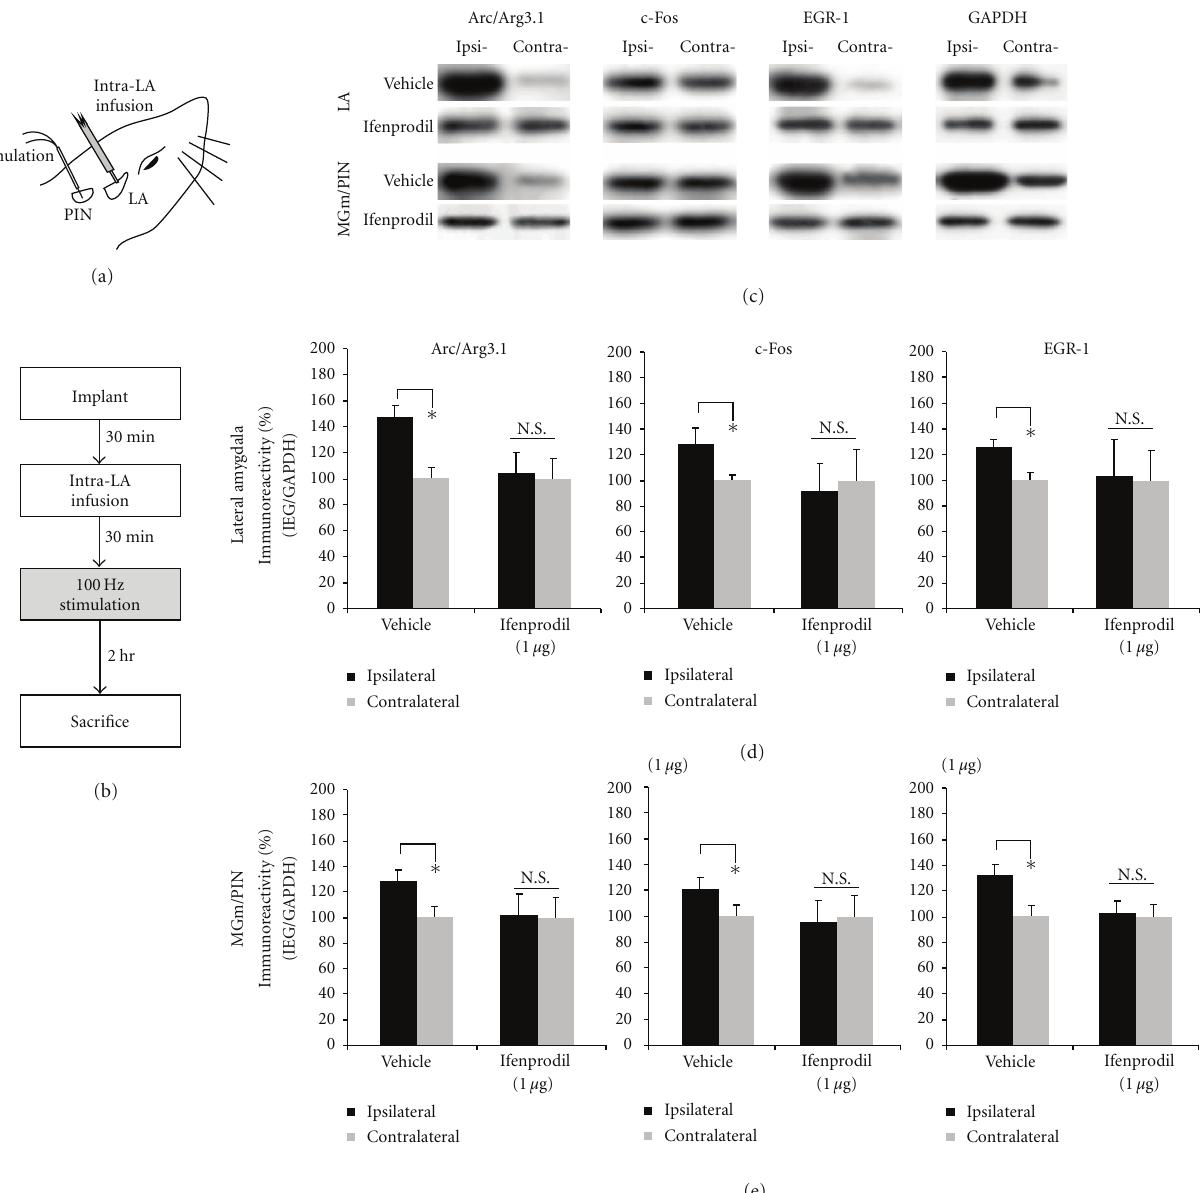
Figure 6: Pharmacological blockade of NMDAR-driven synaptic plasticity impairs ERK-driven IEG expression in both the LA and MGm/PIN following HFS. (a) Placement of stimulation electrode and infusion cannula. (b) Schematic representation of experimental protocol. Rats were given intra-LA infusion of the vehicle or 1 μ g ifenprodil followed 30min later by HFS of the MGm/PIN. Rats were sacrificed 2 hours after stimulation. (c) Images of Western blots for Arc/Arg3.1, c-Fos, EGR-1 and GAPDH from both LA (top)